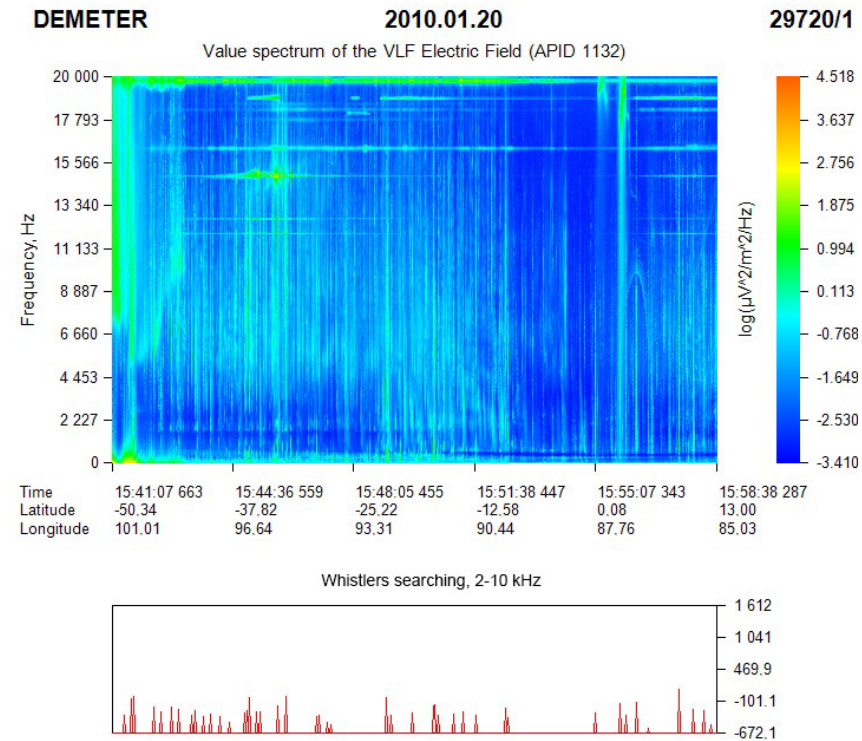
Figure 4. Spectrogram of the electric field in the VLF band with the result of searching for whistlers (vertical red lines on bottom graph) with a coefficient of